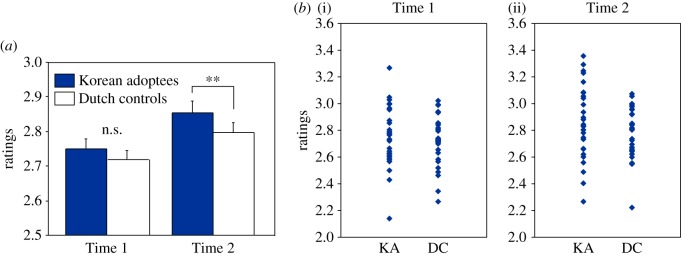
(a) Mean ratings for adoptees' versus Dutch controls' productions at Times 1 and 2 (error bars represent standard errors; **p < 0.01) and (b) ratings at individual speakers' first (i) and second (ii) production times as a function of group (KA, Korean adoptees; DC, Dutch controls).